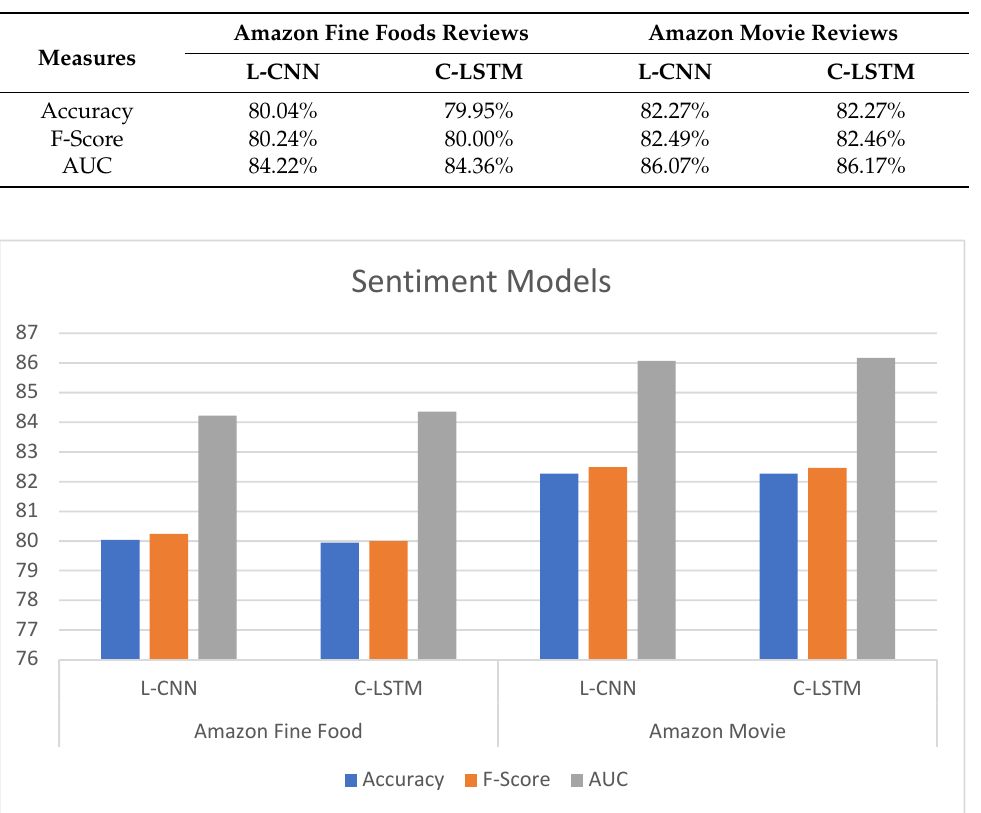
Figure 5. Sentiment performance of hybrid deep-learning models using BERT.